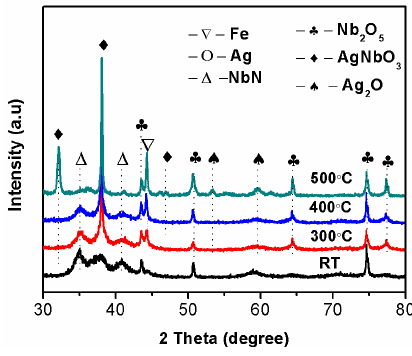
Figure 12. XRD patterns of NbCN-12.9 at% Ag composite films after sliding at different temperatures. For NbCN-12.9 at.% Ag films after sliding at 500 °C (Figure 13b), the Raman spectrum from